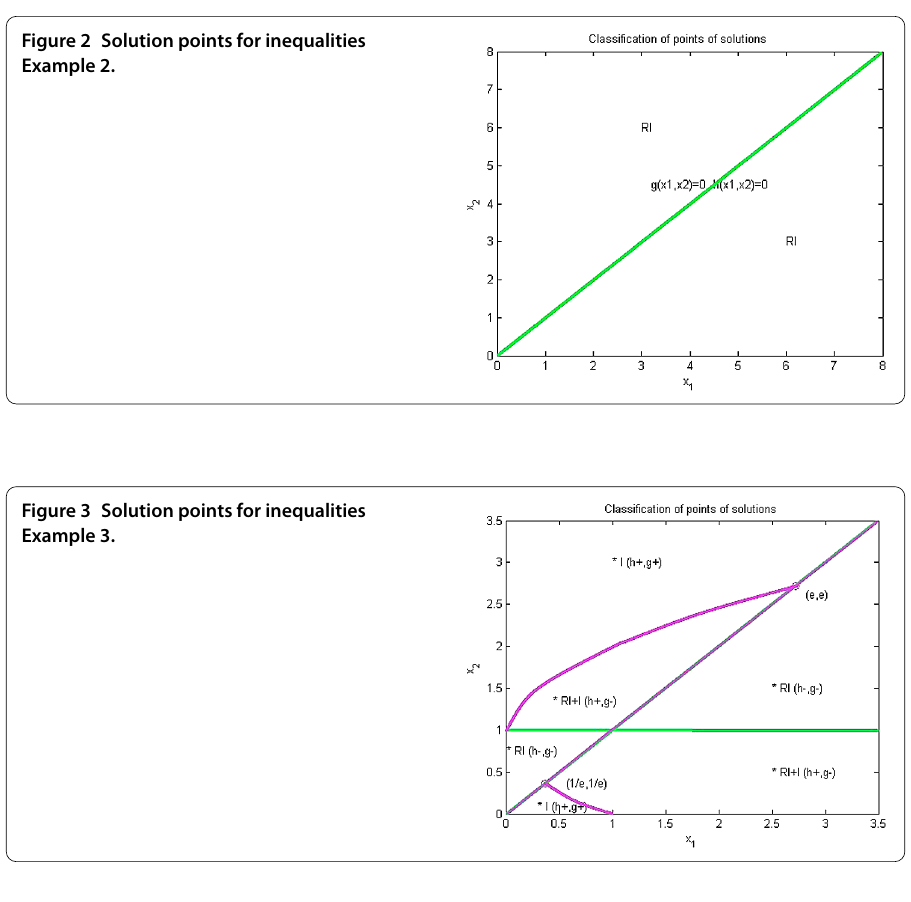
Figure 2 Solution points for inequalities Example 2.